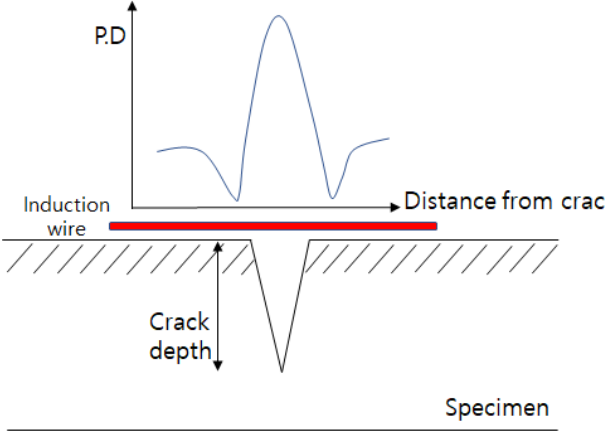
Figure 7. Potential drop distribution for crack.